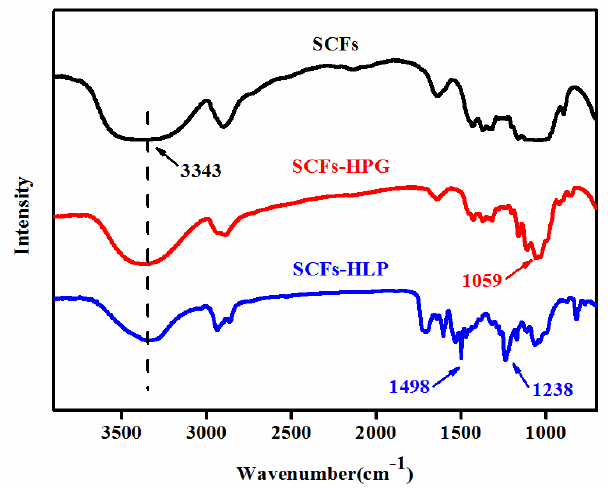
Figure 1. FTIR spectra of sisal cellulose fibers (SCFs), Hyperbranched Polyglycerol modified SCFs (SCFs-HPG) and Hyperbranched liquid crystals modified SCFs (SCFs-HLP).